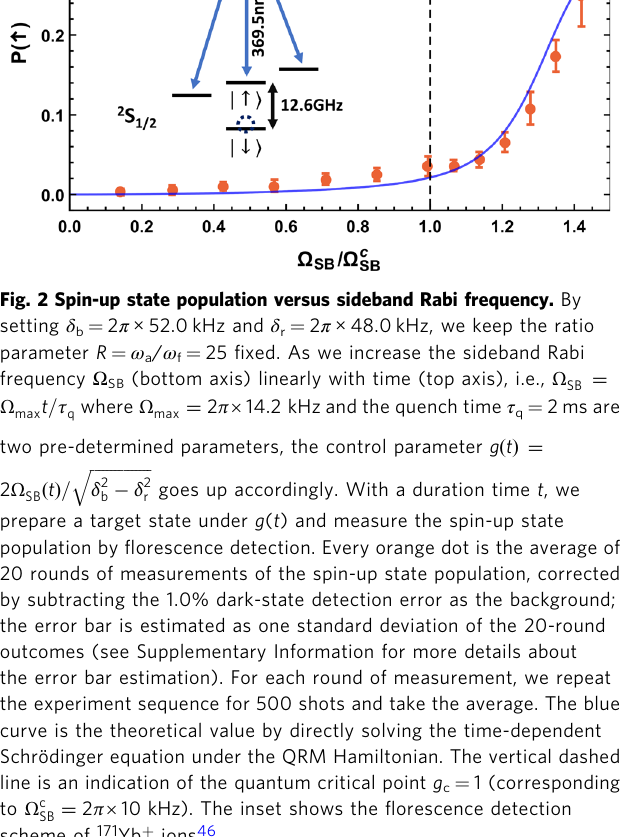
¼ SB = 2 ms are q